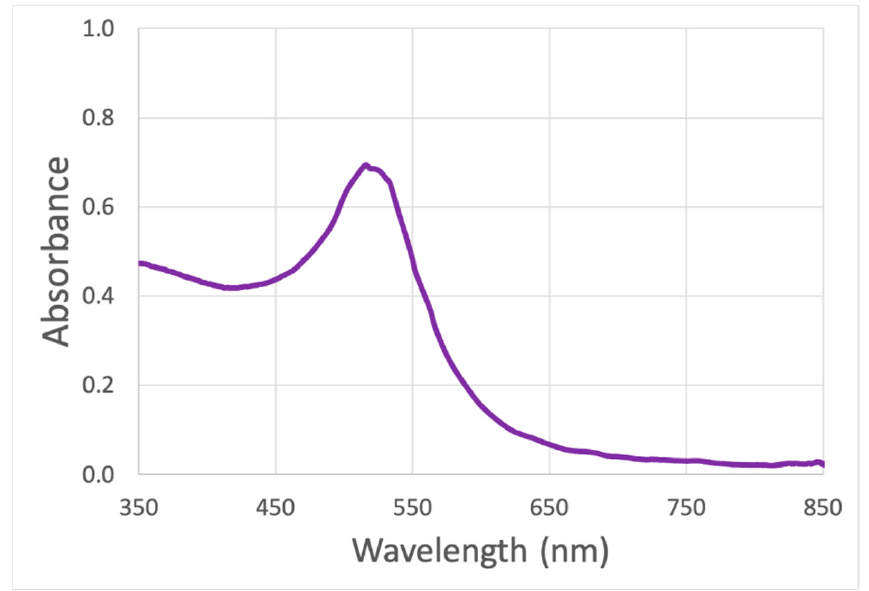
Figure 1. UV/Vis-absorption spectrum of the Au NPs’ suspension showing its LSPR and interband absorptions.